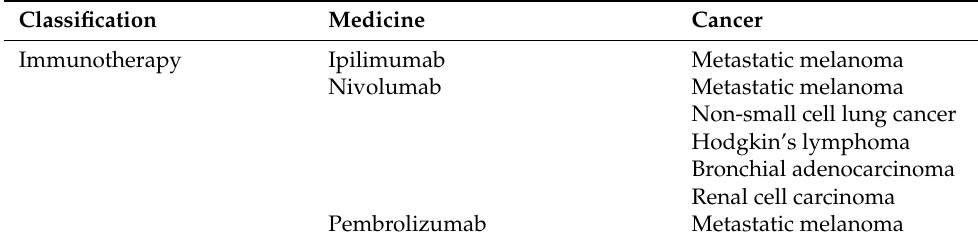
Table 1. Indications of tumour drugs mentioned in the